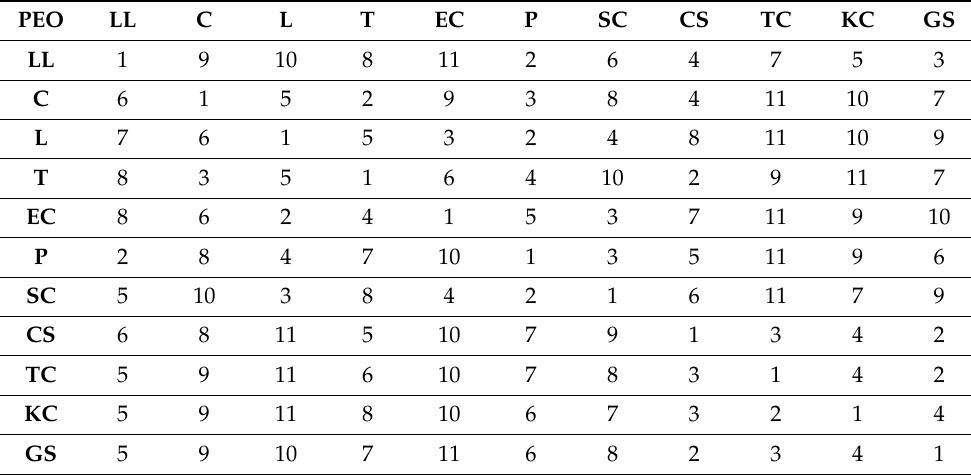
Table 8. PEOs similarity ranking based on CS